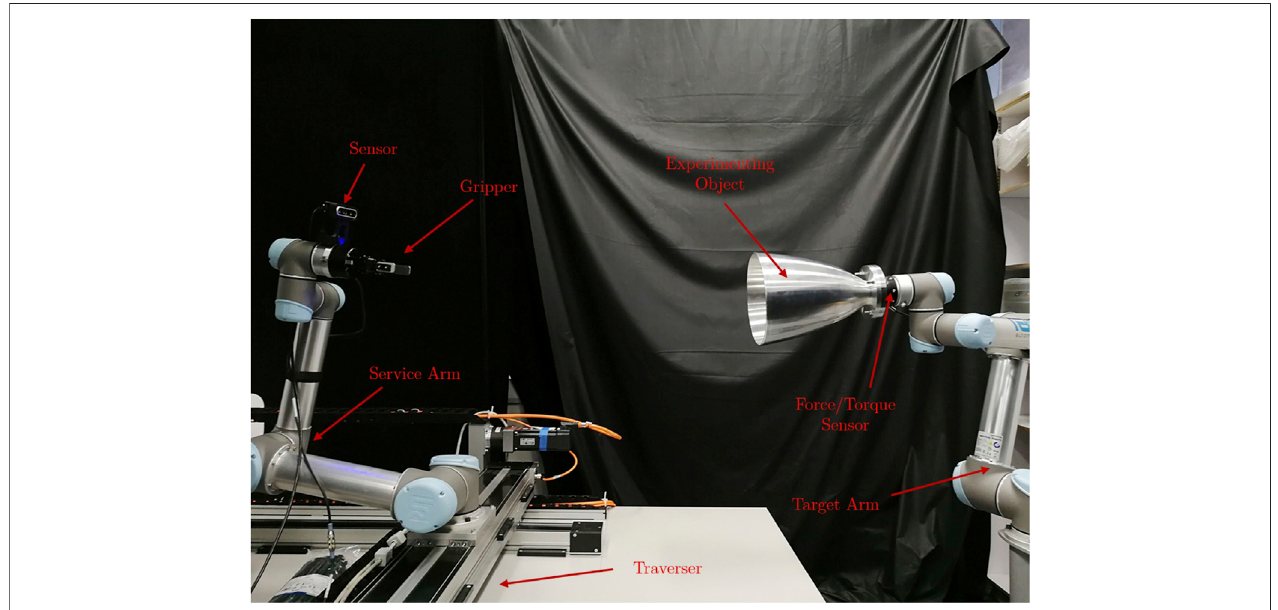
FIGURE 3 | The nominal con fi guration of the STAR LAB ’ s orbital robotic testbed for the experiment of grasping of a spend rocket stage. The sensor is Intel RealSense D435. The gripper is RobotiQ 2F-85. The force torque sensor is RobotiQ FT300.